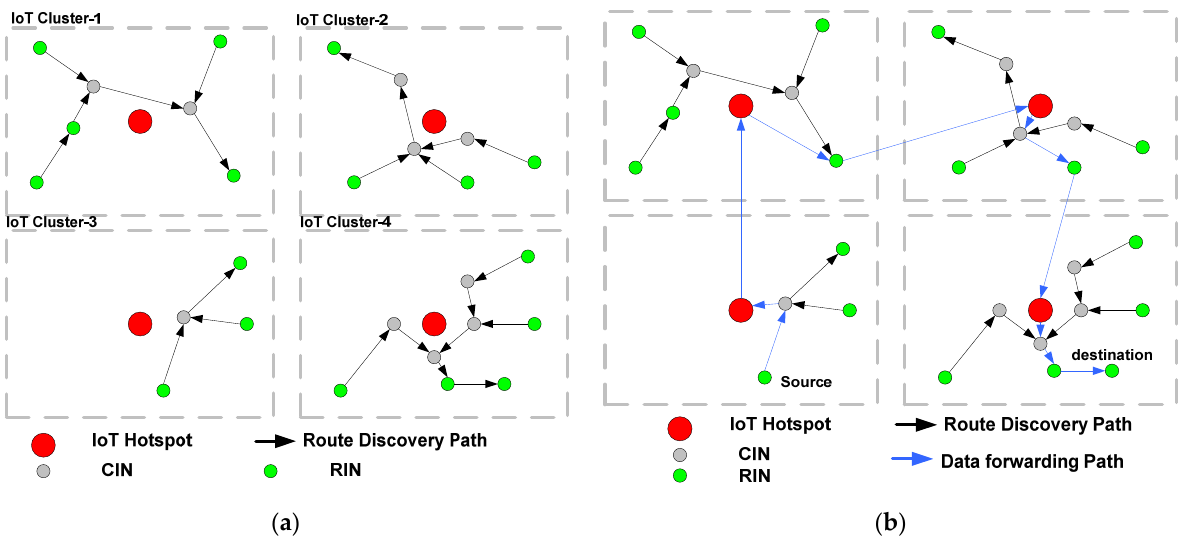
Figure 5. Simulation environment of the proposed scheme: ( a ) IoT cluster formation and routing initiation; ( b ) Inter-cluster data forwarding.